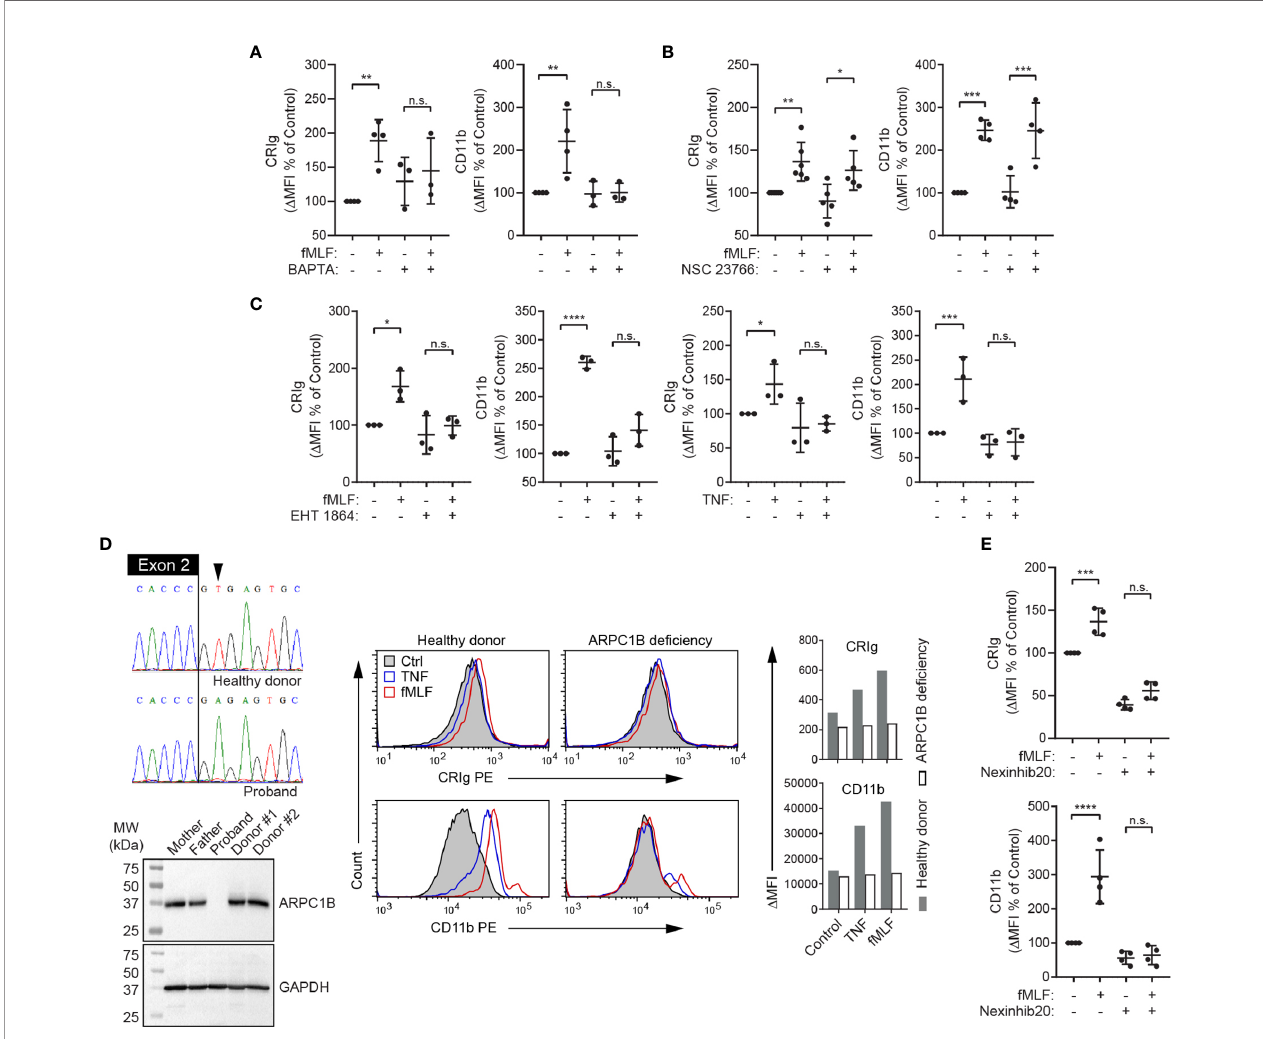
FIGURE 5 | Expression of CRIg on the neutrophil surface is dependent on intracellular calcium, Rac, ARPC1B and Rab27a. (A – C) , Surface CRIg and CD11b expression was measured on neutrophils challenged with 10 -6 M fMLF, following pre-treatment with either 25 m M of Ca 2+ chelator, BAPTA-AM for 30 min, 50 m M of the Rac-1 inhibitor, NSC 23766 for 1 h, or 100 m M of the Rac-1/Rac-2 inhibitor, EHT 1864, for 30 min. The effect of EHT 1864 was also examined on TNF (10 3 U/ mL)-induced CRIg and CD11b expression. (D) Sequence electropherograms of the end of ARPC1B exon 2 and fl anking intron in a healthy donor and a patient with a splice-site substitution (LRG_1188t1:c.64+2T>A). The resulting de fi ciency in ARPC1B is shown in the Western blot showing absence of the protein in neutrophil lysate compared to parental and other healthy donor neutrophils. Flow cytometric histograms present a lack of up-regulation of cell surface CRIg and CD11b in response to TNF is ARPC1B-de fi cient neutrophils. Graphs show mean D MFI of two experiments. (E) Surface CRIg and CD11b expression was measured on neutrophils challenged with 10 -6 M fMLF, following pre-treatment with 20 m M of Rab27a inhibitor, Nexinhib20, for 1 h. Expression was assessed as described in Figure 1 with either D MFI per se or as a percentage increase over control treatment. Measurements were taken from distinct specimens and graphs show mean ± SD of these measurements. One-way ANOVA with Sidak ’ s post-test compared between fMLF/TNF treatment and control or fMLF/TNF in the presence of inhibitor. Signi fi cance levels are indicated by asterisks: * P < 0.05, ** P < 0.01, *** P < 0.001, **** P < 0.0001, n.s., not signi fi